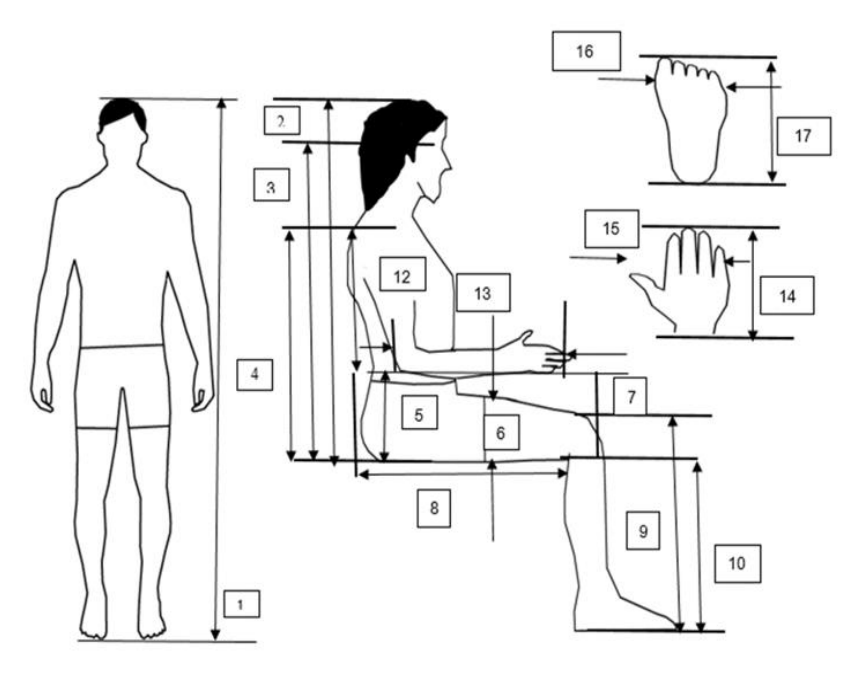
Figure 1 . Anthropometric measured